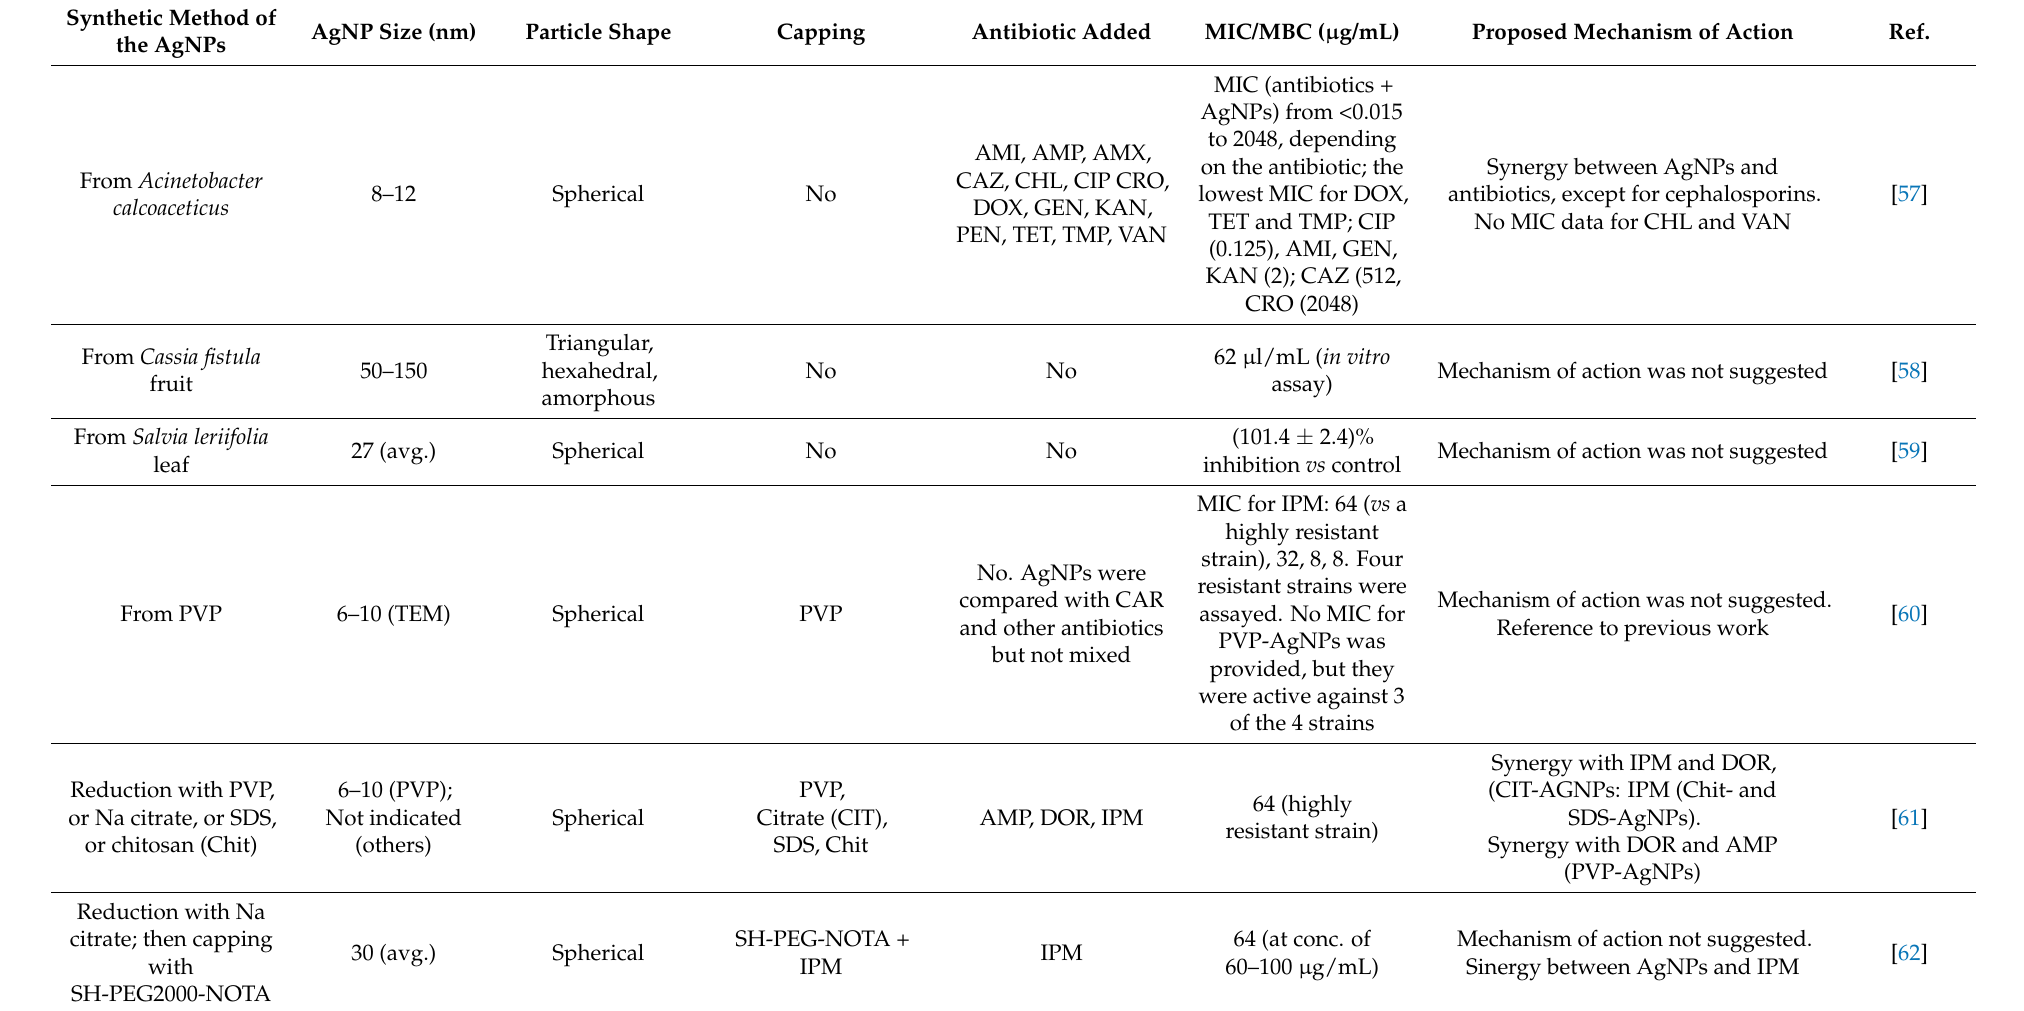
Table 1. Research on the activity of AgNPs against A. baumannii in vitro